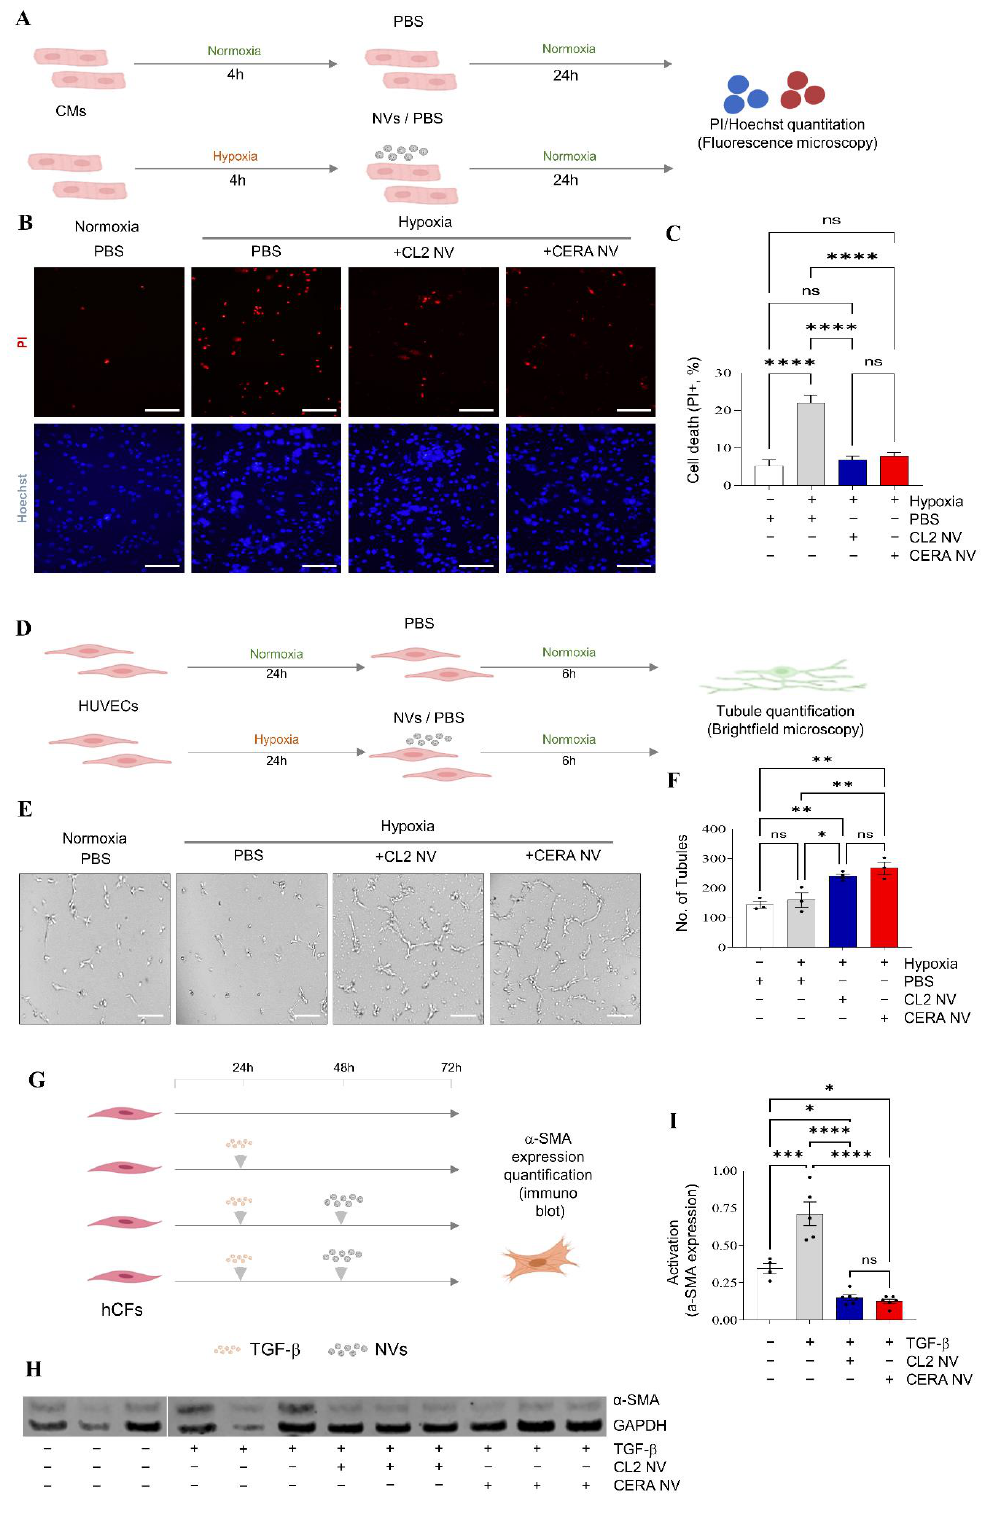
Figure 4. iPSC NVs functionally regulate aspects of cardiac repair in vitro. ( A ) Cardiomyocyte (CM) survival assay, where cells are exposed to hypoxia/normoxia (4 h) and treated with NVs under